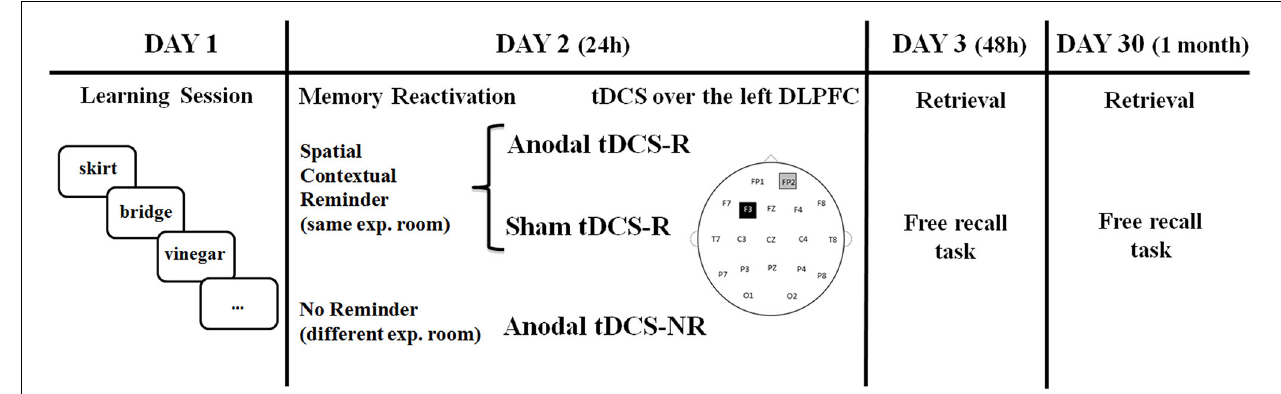
FIGURE 1 | Timeline of experiment. Older adults learned 20 words on Day 1. On Day 2 (24h later), they received a reminder or not, and after 10min tDCS was applied over the left DLPFC. Memory retrieval (free recall) was tested on Day 3 (48h later) and Day 30 (1 month